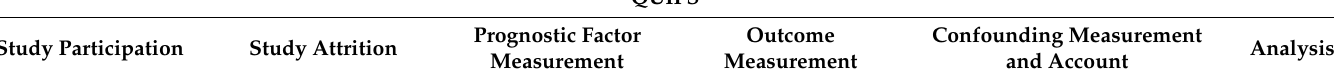
Table 4. QUIPS tool for assessing risk of bias in the clinical studies.